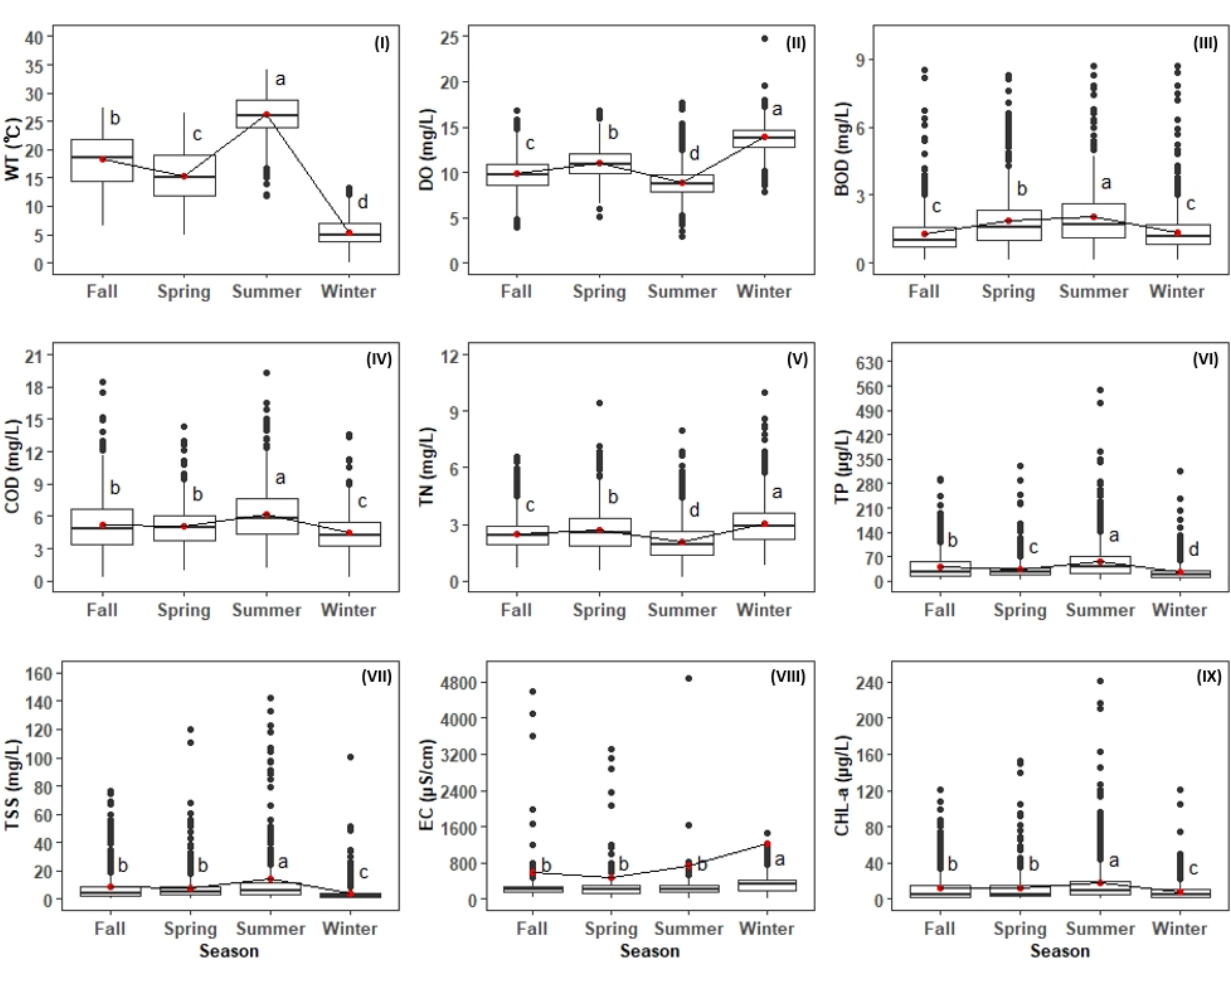
Figure 4. Seasonal variations in water quality parameters in the Nakdong River basin.